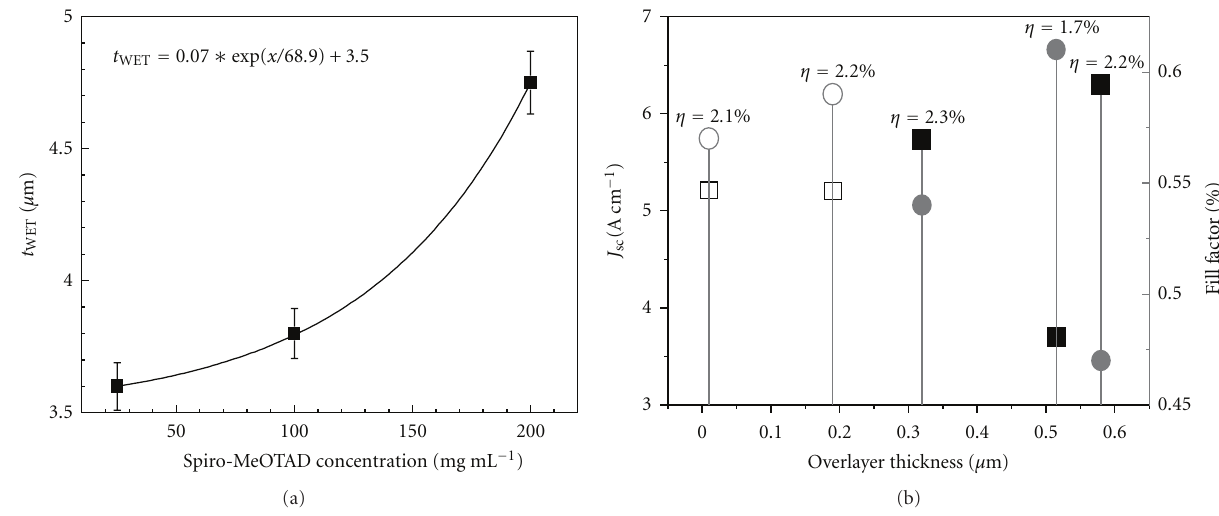
Figure 4: (a) Wet layer thickness ( t WET ) as a function of the spiro-MeOTAD concentration, fitted with an exponential. (b) Short circuit currents (squares) and fill factors (circles) for ssDSCs as a function of spiro-MeOTAD overlayer thicknesses, for spiro-MeOTAD concentrations of 100mg mL − 1 (open symbols) and of 200 mgmL − 1 (closed symbols).